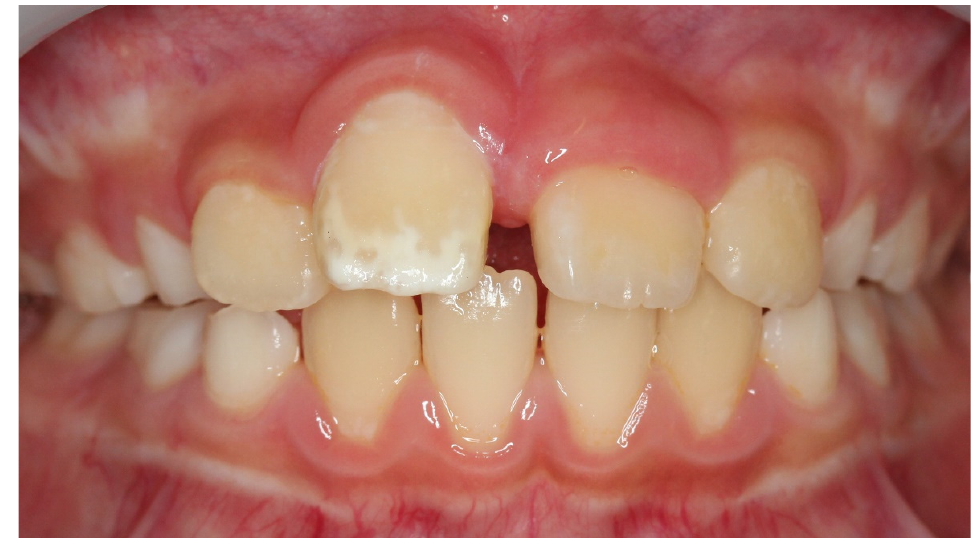
Figure 6. Case 2: Intraoral photograph before treatment.